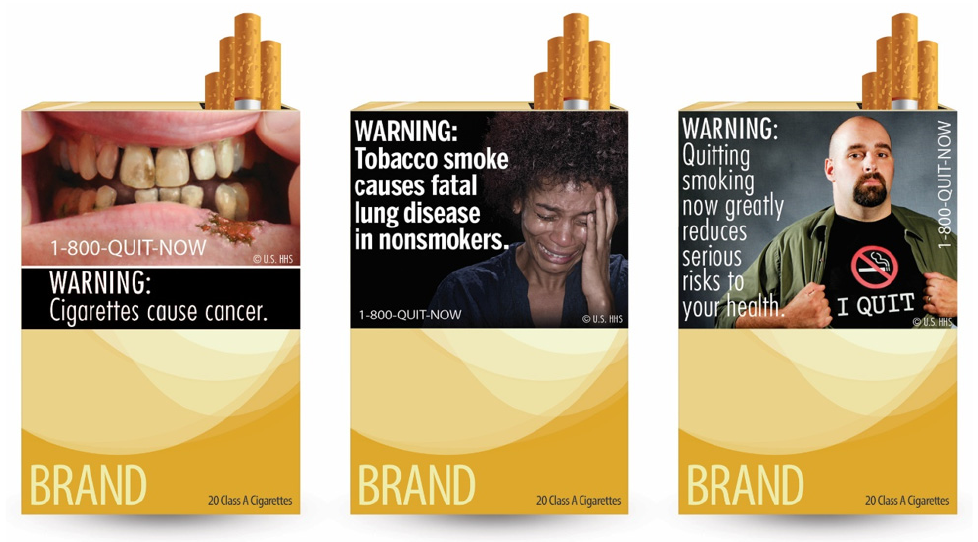
Figure 1. The FDA’s proposed cigarette labels from 2011